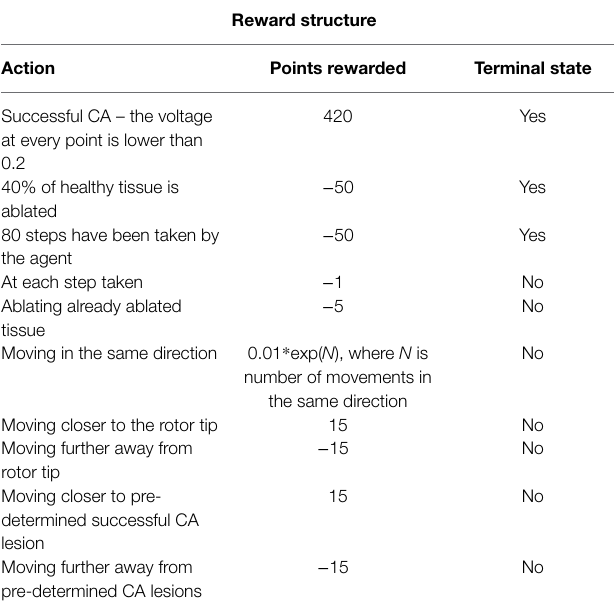
TABLE 1 | Summary of the reward structure, how many points the agent receives as a reward and whether it is a terminal state. Reward